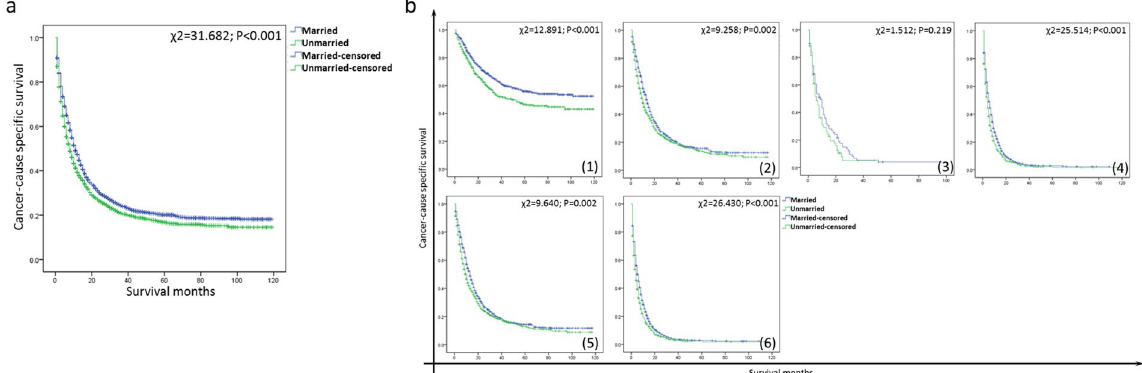
Figure 1. Survival curves of married and unmarried GBC patients. ( a ) All stages: χ 2 = 31.682, P < 0.001; ( b ) (1) stage I: χ 2 = 12.891, P < 0.001; (2) stage II: χ 2 = 9.258, P = 0.002; (3) stage III: χ 2 = 1.512, P = 0.219; (4) stage IV: χ 2 = 25.514, P < 0.001; (5) stage II + III: χ 2 = 9.640, P = 0.002; (6) stage III + IV: χ 2 = 26.430, P < 0.001.